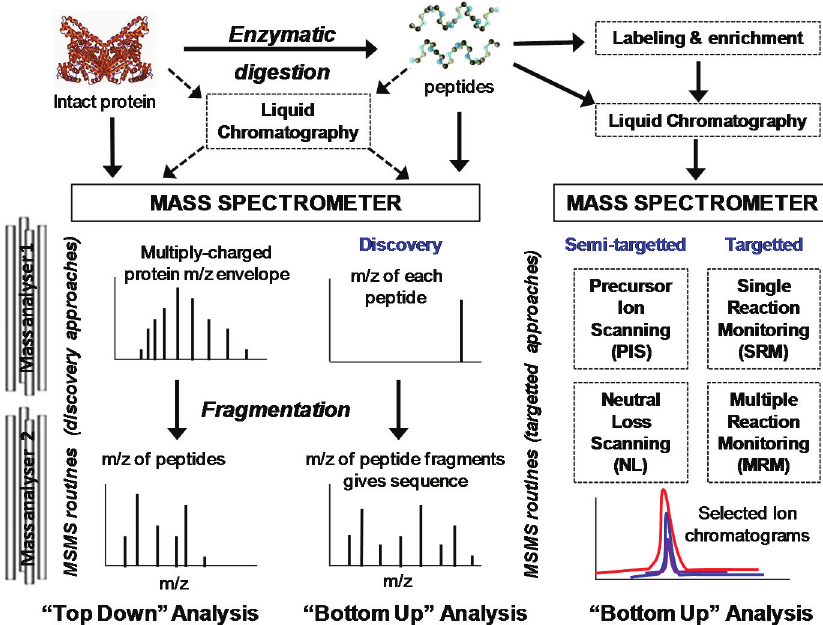
Figure 2. Summary of advanced methods for identification of proteins and oxPTMs.